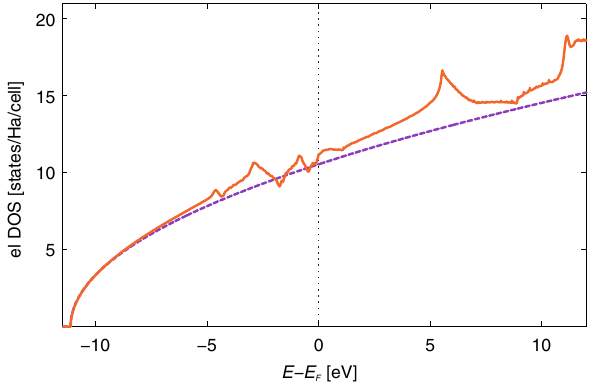
FIG. 7. DFT calculation of the electronic density of states in aluminium. The dashed line illustrates the e